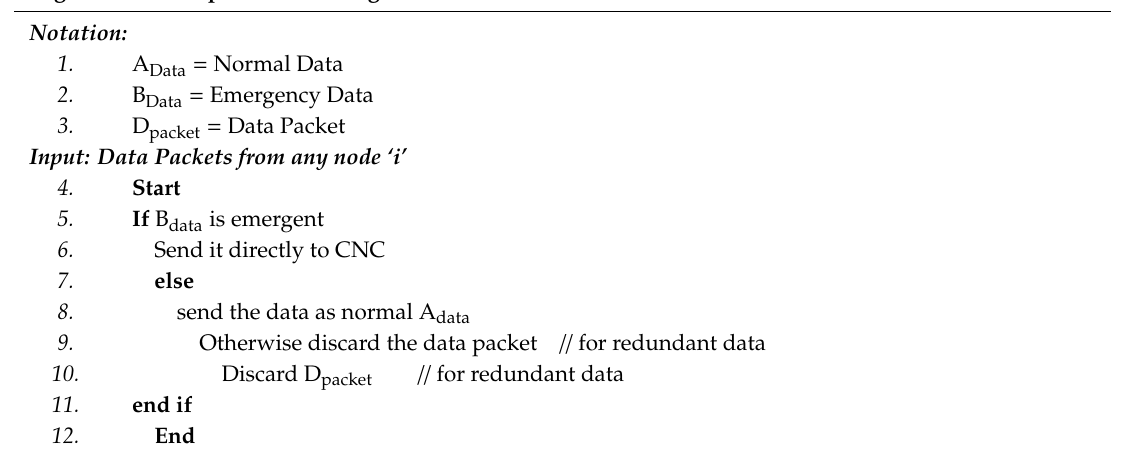
Algorithm 3: Cooperative